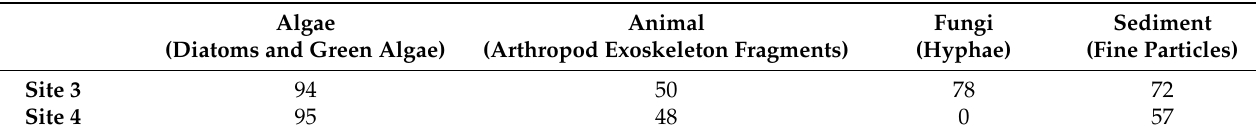
Table 1. Gut contents from 39 Hydropsyche alternans larvae from two sites on the south-central shore of Lake Superior. Values are percentages of individuals that had recognizable remnants of the specified item in their guts. All guts also contained amorphous organic matter.